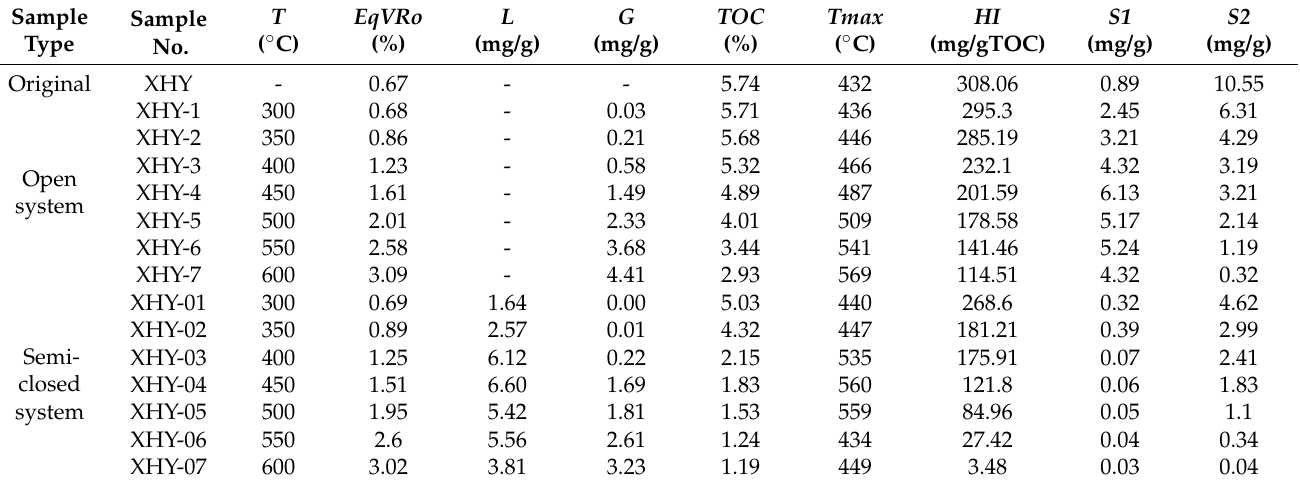
Table 2. Results of open and semi-closed pyrolysis experiments and Rock-Eval pyrolysis